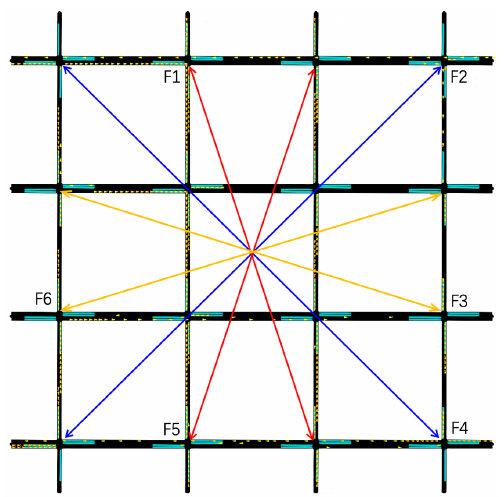
Figure 2. A traffic grid of 16 intersection with time-variant traffic-flow groups. Taking Figure 3 as an example, the horizontal axis represents the number of training times, and the vertical axis represents the average cumulative reward. The thicker lines represent changes in workers’ average reward. This reward represents the environmental reward of the worker so that our curve can more clearly measure the intuitive change traffic lights make to the environment. The shaded part refers to the standard deviation of the experimental results, which represents the fluctuation in the algorithm performance. We used five sets of random seeds to verify each algorithm to reflect the average performance of the algorithm.